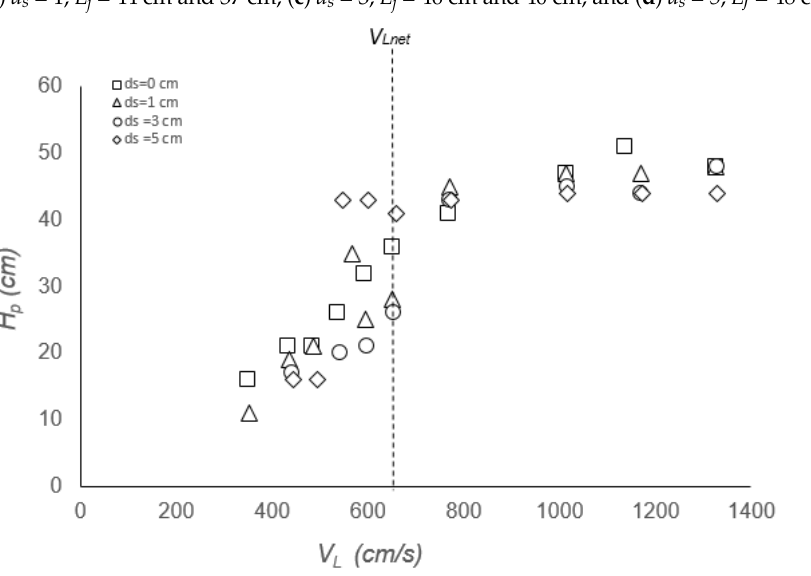
Figure 12. Effect of penetration depth as flowrate increases for different d s spacing for l ADR = 40 cm.